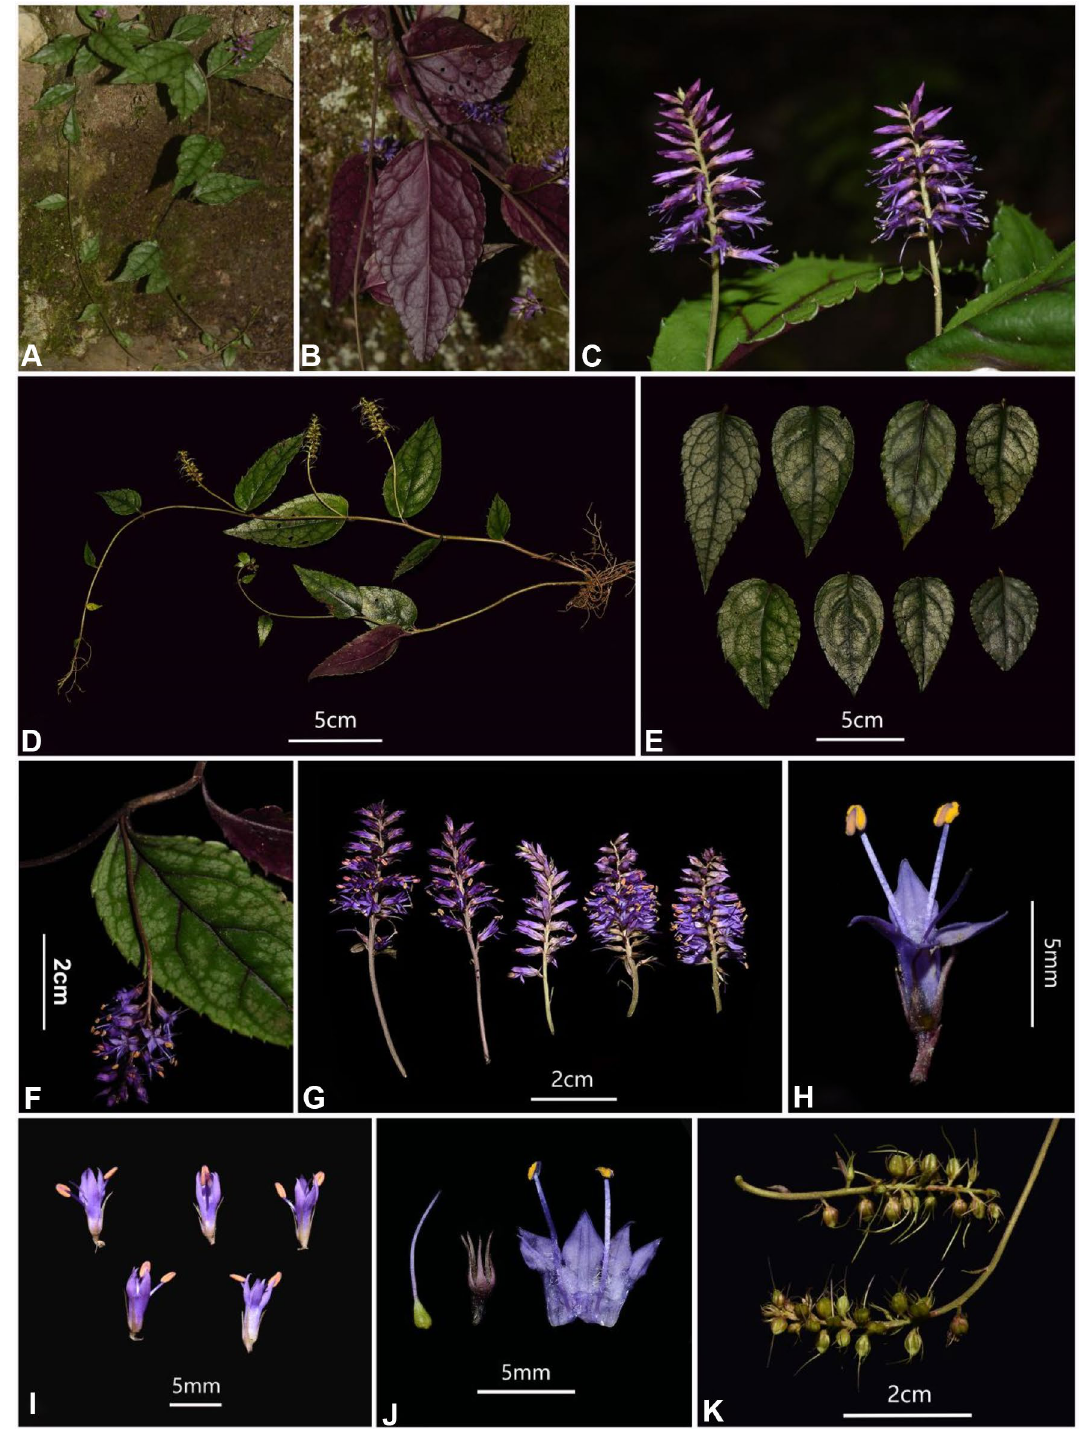
Fig. 1 Veronicastrum wulingense (type locality). A–B habit; C leaf sawtooth; D individual; E leaves; F axillary inflorescence in the main axis; G inflorescences; H–I flowers; J anatomical flower; K infructescences. Photographed by S.X.